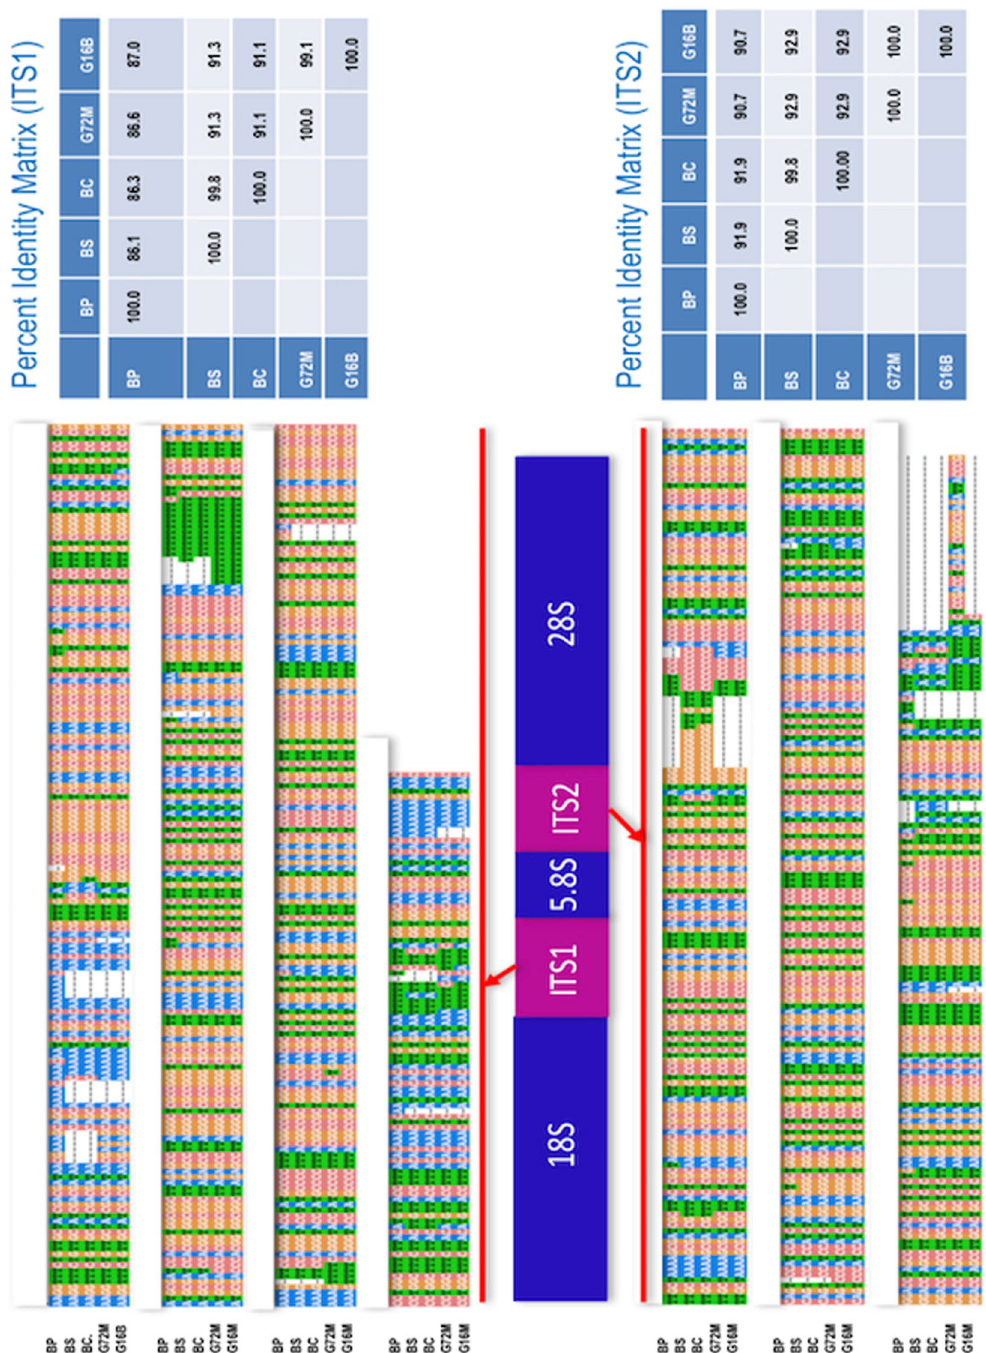
Figure 5. Gene segment of rDNA cassette. Alignments of ITS1 and 2 sequences are shown and percent identity matrixes are provided on the right